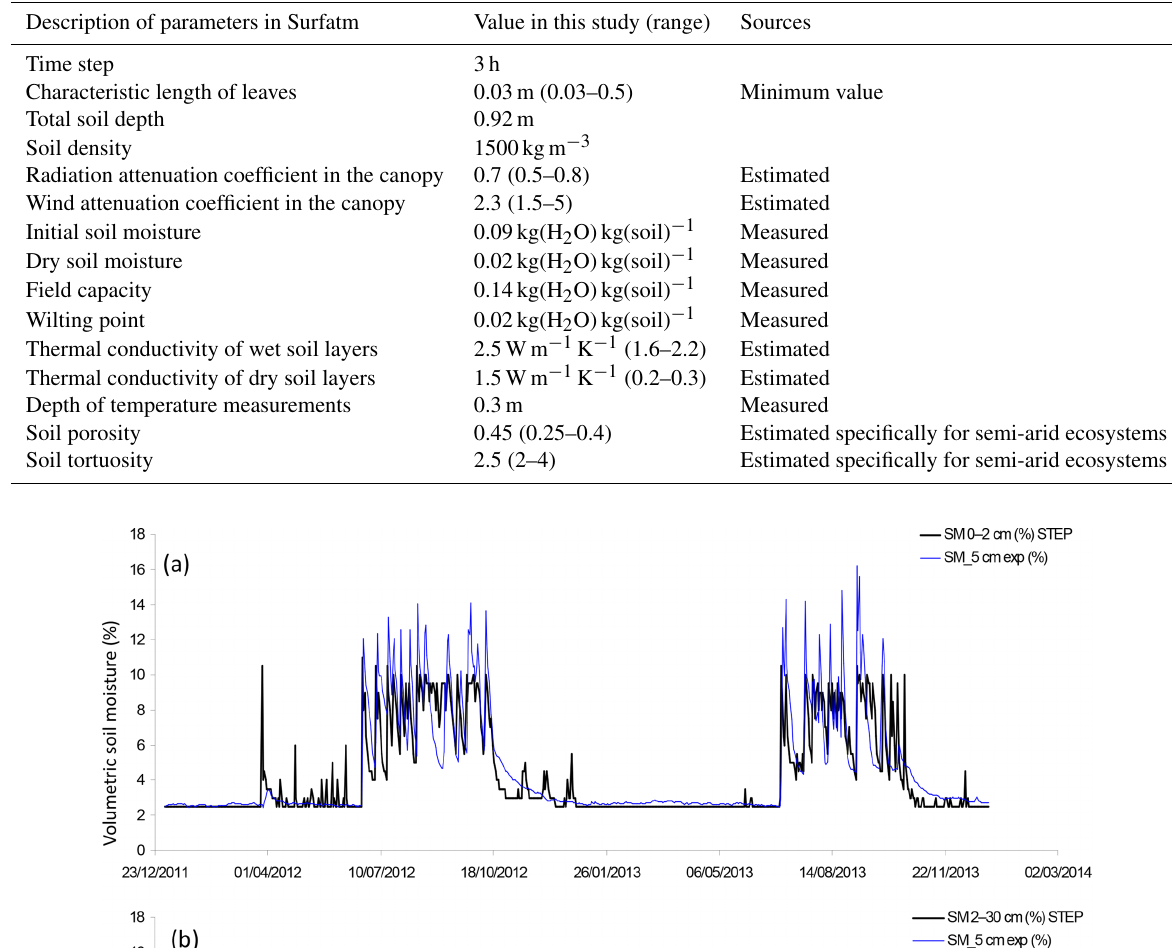
Table 2. Input parameters for the Surfatm model. Ranges refer to Hansen et al. (2017). All measured parameters refer to Delon et al. (2017). Description of parameters in Surfatm